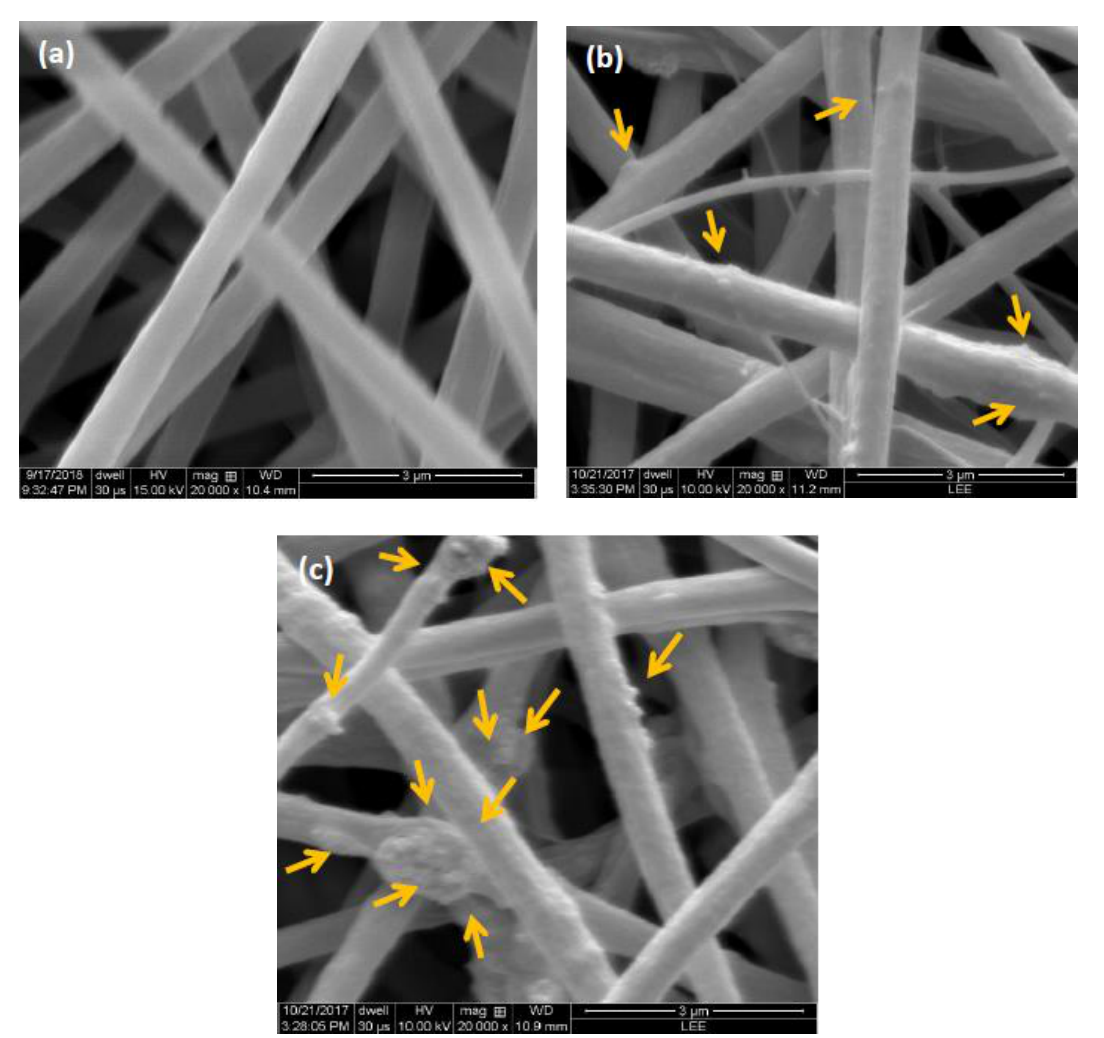
Figure 2. SEM images of electrospun nanofibers ( a ) poly(methyl methacrylate)/poly(vinyl pyrrolidone (PMMA/PVP), ( b ) PMMA/PVP-Ag 3 PO 4 /P25 before washing, and ( c ) PMMA/PVP-Ag 3 PO 4 /P25 after washing.